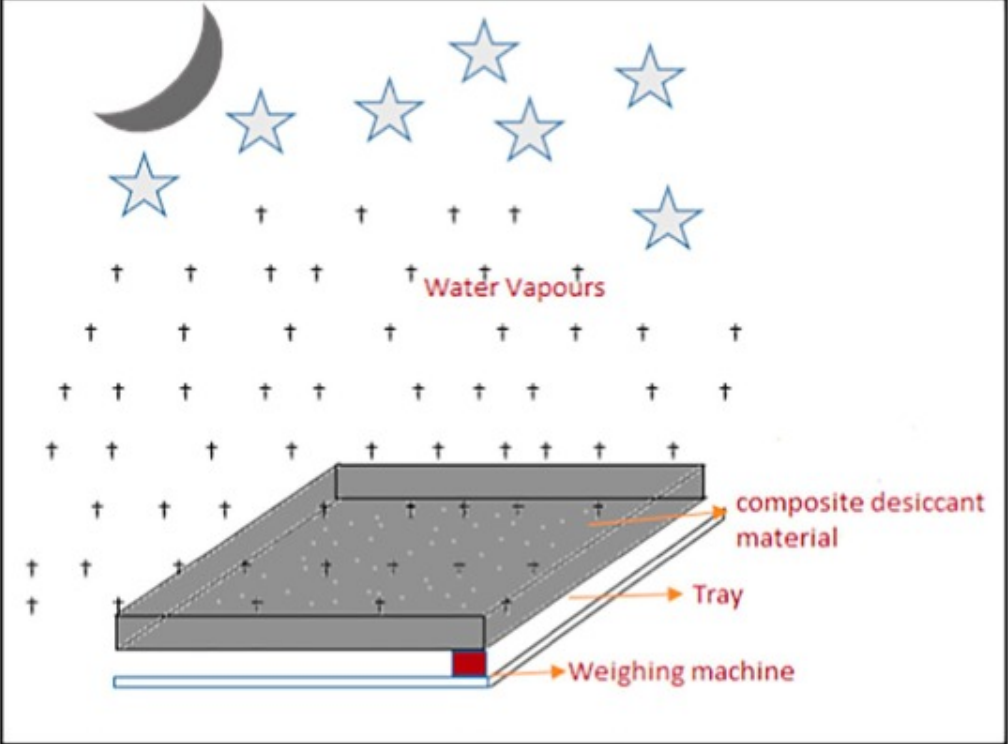
Figure 13. Schematic diagram of water generation by composite desiccant material using fixed focus concentrator during the day (adapted with permission from Reference [66], Copyright 2018, Elsevier).